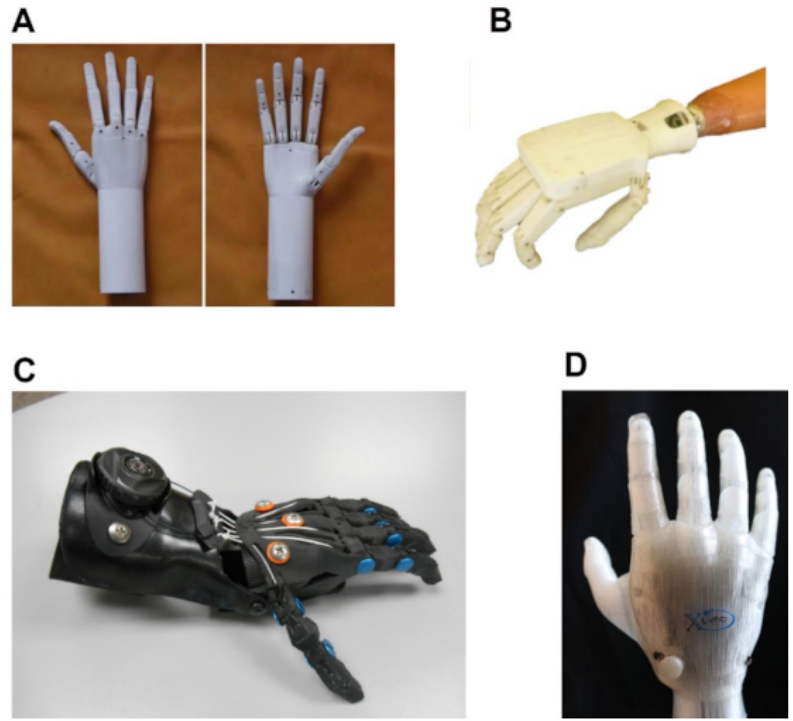
Figure 9. 3D printed hand prosthesis. ( A ) Andrianesis’ Hand, ( B ) Touch hand II, ( C ) Cyborg beast and ( D ) X-Limb. Reprinted with permission from